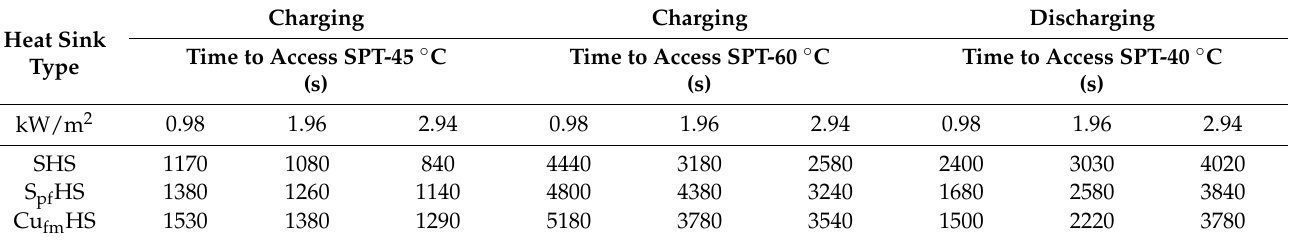
Table 5. Working time enhancement of heat sinks at various SPTs.